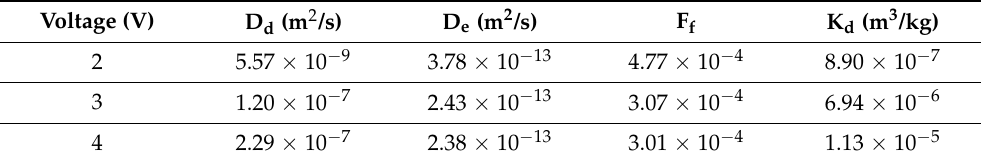
Table 4. Parameter evaluation of the breakthrough curves of Sr 2+ migrating through the rock sample using the advection-dispersion model.